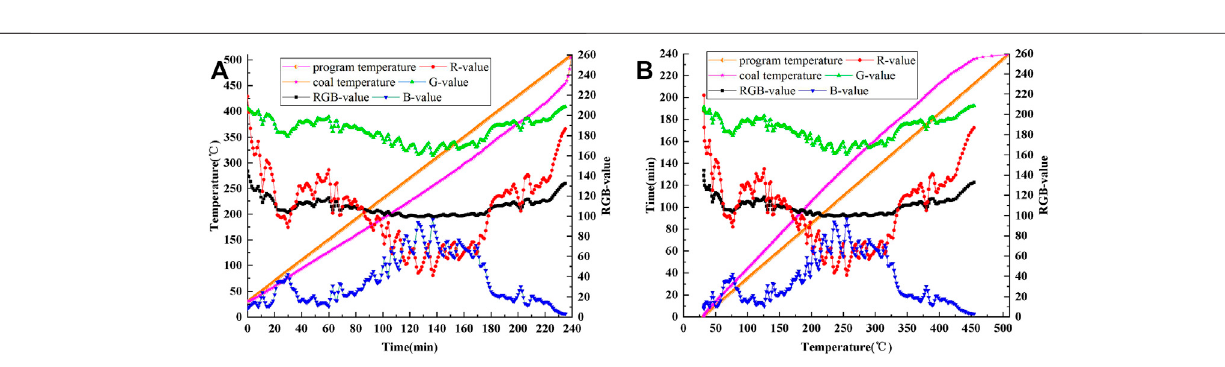
Frontiers in Materials |